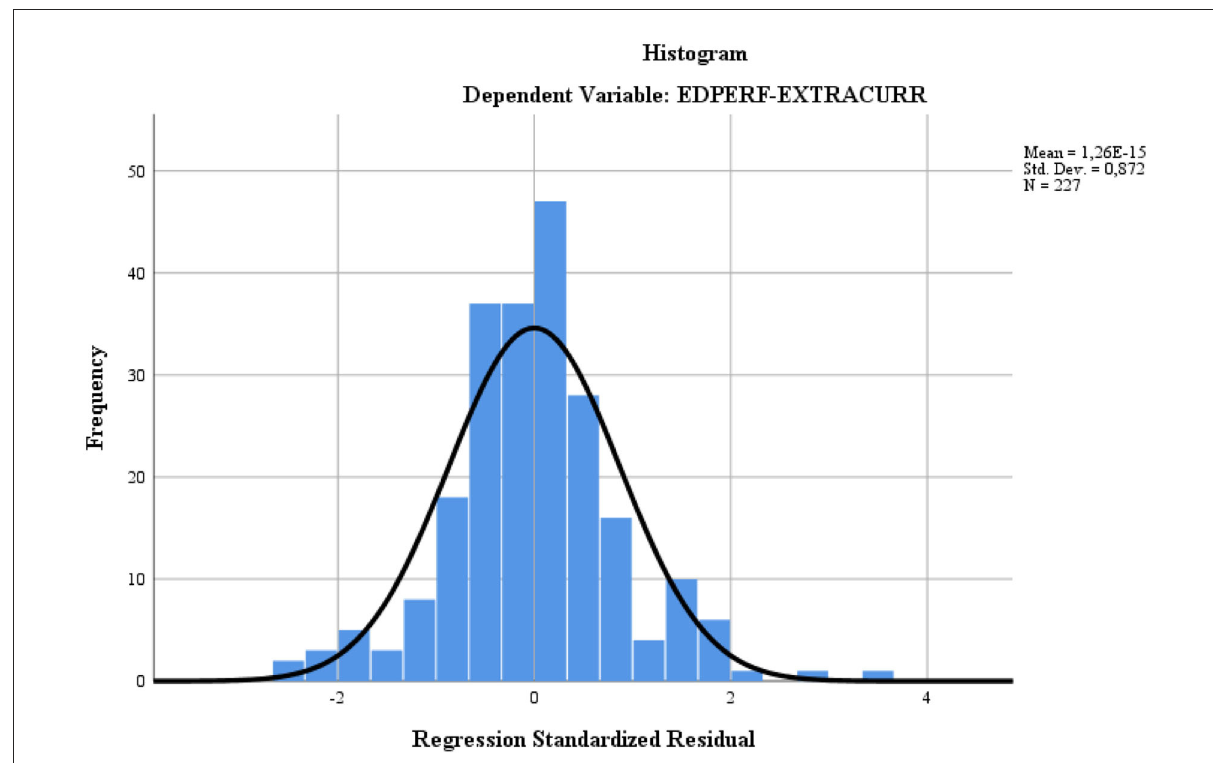
FIGURE4 Histogram distribution of the motivational